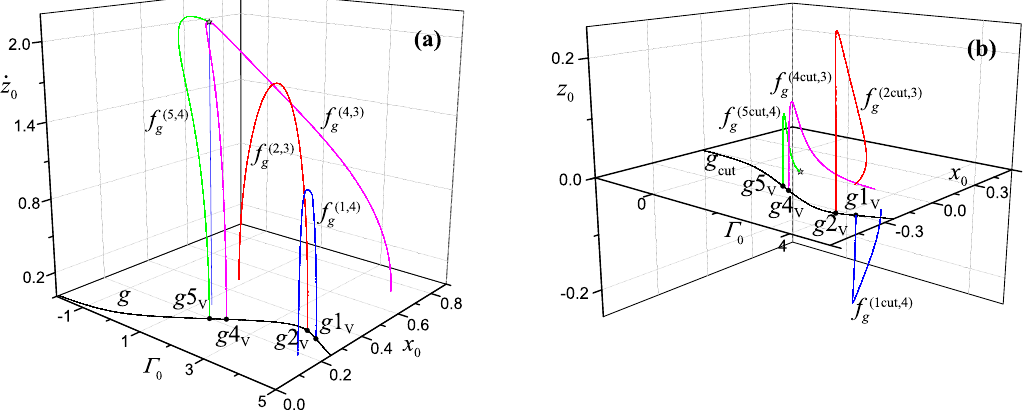
Figure 4. 3D families bifurcating from the VSR orbits gi v , i = 1,2,4,5 of family g . ( a ) Bifurcating families starting from the initial condition ( Γ 0 , x 0 ) of the planar family and ( b ) Bifurcating families starting from the initial condition ( Γ 0 , x cut ) of the planar family. Grey star indicates that a family goes to collision